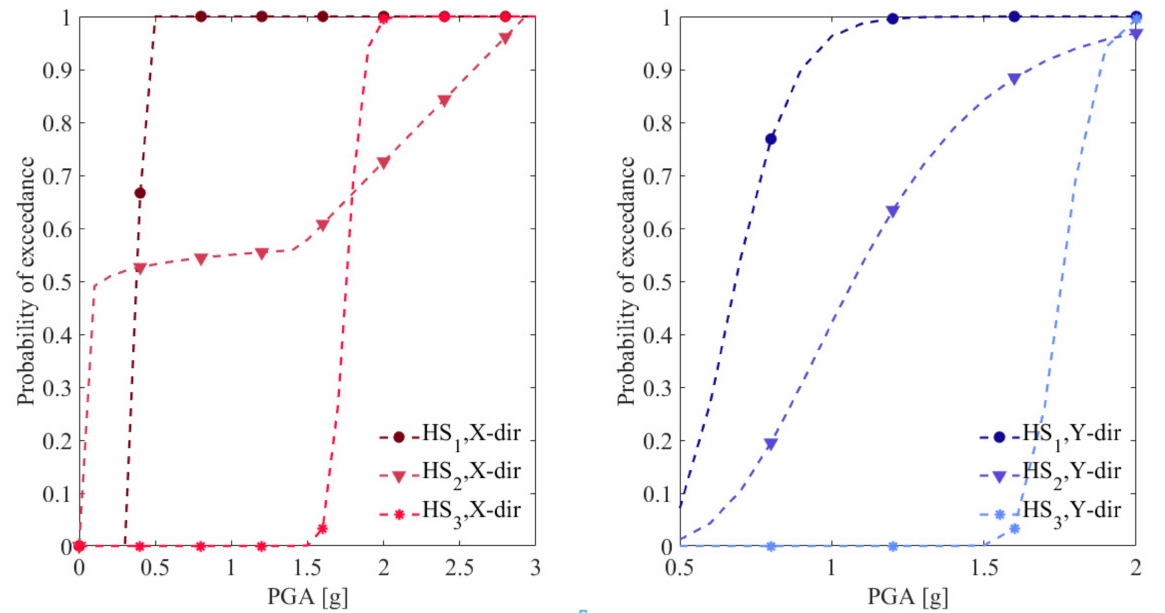
Figure 19. Fragility curves of buildings for the two main directions of the building, at varying the floor